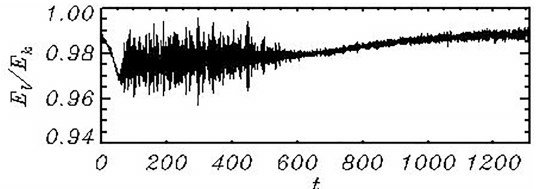
Figure 13. Time evolution of the ratio E l /E k